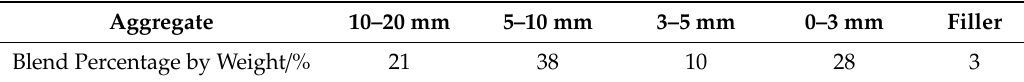
Table 1. Aggregate stockpile blend